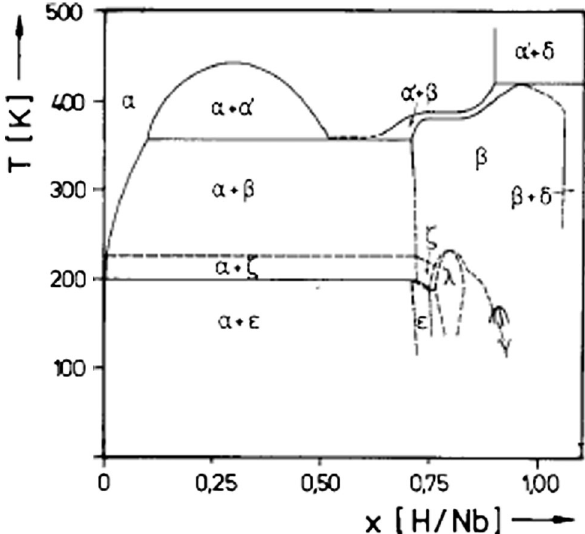
FIG. 1. Phase diagram of Nb-H system (from Ref.